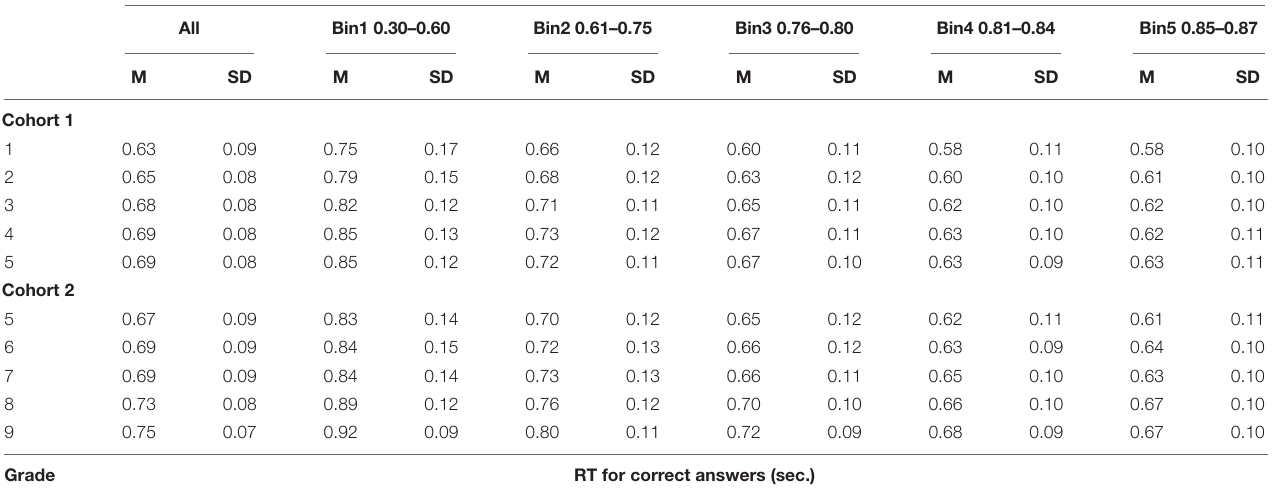
TABLE 1 | Descriptive statistics for accuracy and RT for all trials and for five ratio bins.